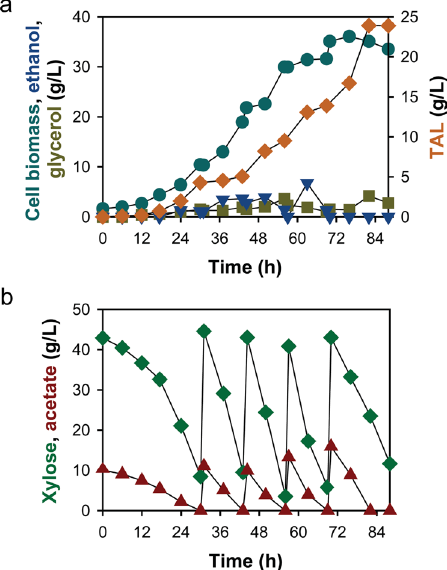
Fig. 5 Fed-batch culture of the Tal4 strain in a 3-L bioreactor with xylose and acetate co-feeding. a Pro fi les of TAL, cell biomass, ethanol, and glycerol concentrations. b Feeding patterns of xylose and acetate. Source data are provided as a Source Data fi le. (Fig. 5a). This may be caused by the toxicity of TAL to yeast cells at high concentrations 32 .